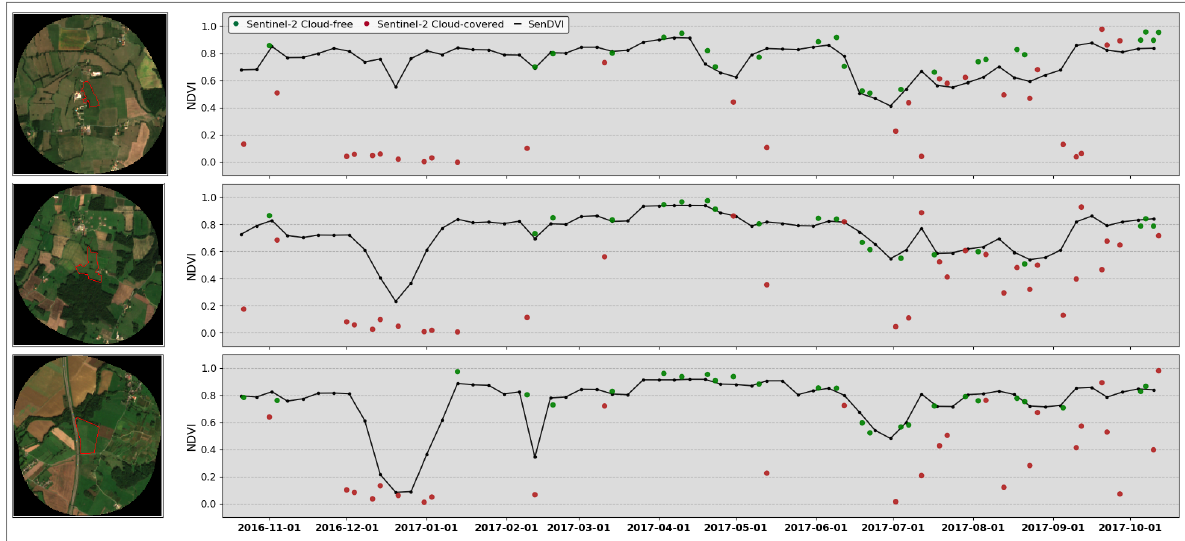
Figure 1. Comparison between predicted NDVI time-series obtained by the SenDVI network and actual Sentinel-2 NDVI values for three grassland parcels ( left ). Green dots indicates valid non-cloudy Sentinel-2 values while red dots are cloudy days (missing data). Black line shows the SenDVI network prediction with high temporal sampling. It follows correctly the non-cloudy values and keep high frequencies of the signal.